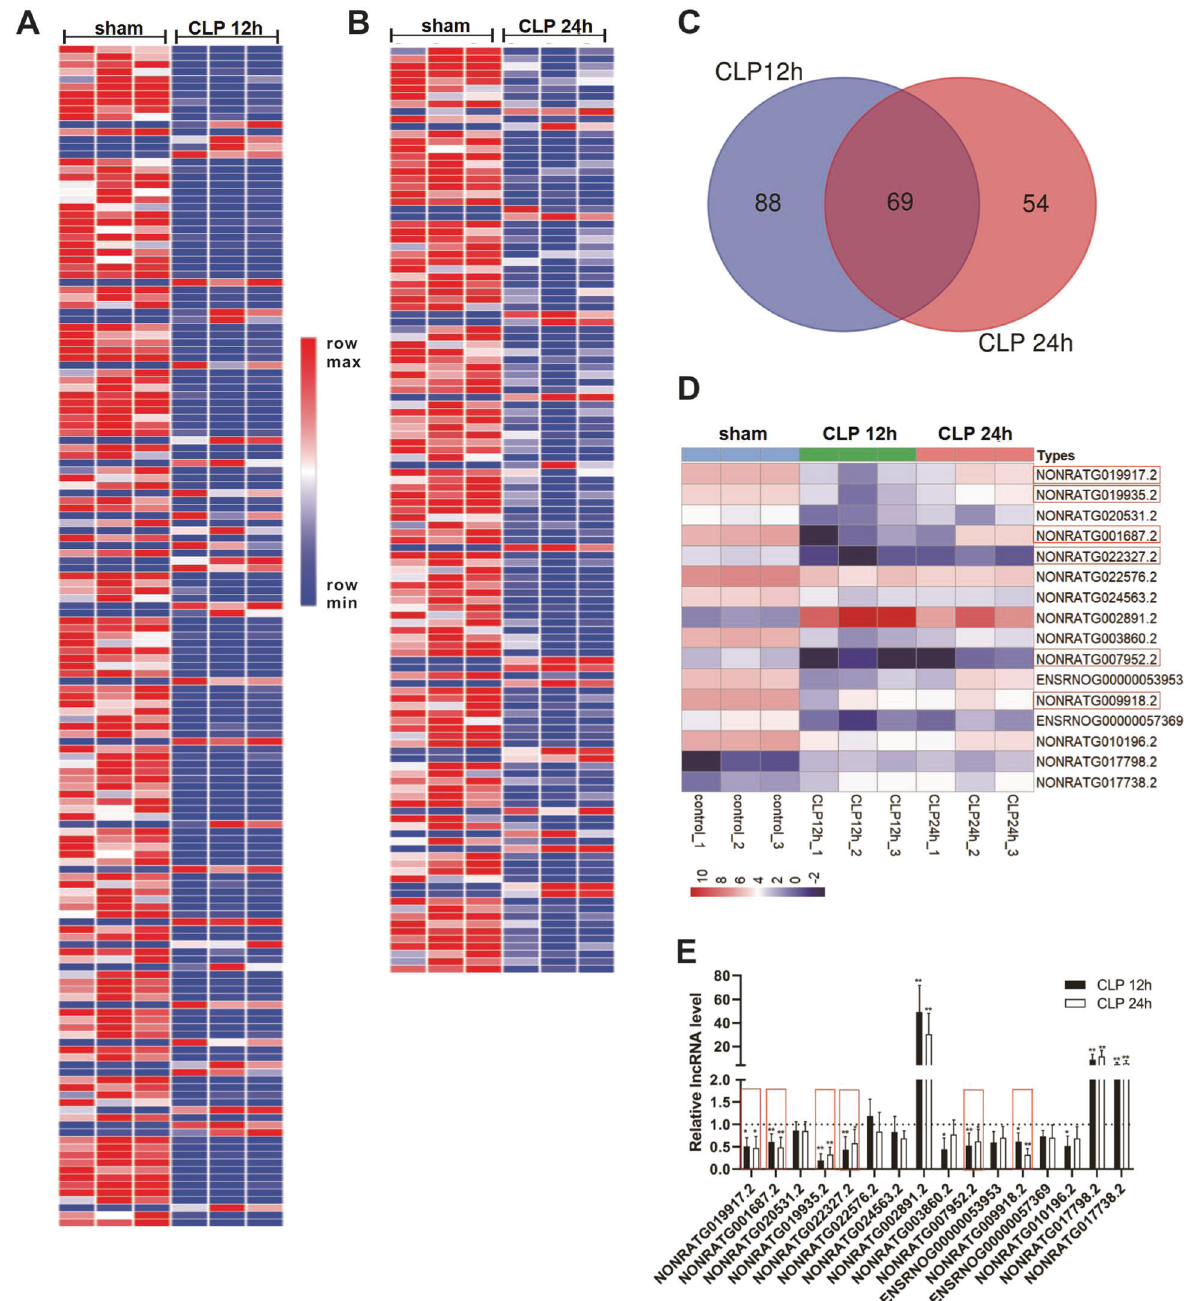
Fig. 1 Identi fi cation of differentially expressed lncRNAs (DE-Lncs) in cecal ligation puncture (CLP)-engendered acute kidney injury (AKI). Clustered heat map of the DE-Lncs in renal cortical of A CLP 12 h ( n = 3) and B CLP 24 h ( n = 3). Rows represent lncRNAs and columns represent tissue types. The color scale runs from blue (low intensity) to white (medium intensity), to red (strong intensity). C There were 69 common DE-Lncs between CLP 12 and 24 h group. D The heat map of the 16 known lncRNAs among 69 common DE-Lncs. E qRT-PCR analysis of the expression levels of 16 known lncRNAs in the renal cortical of rats in each group ( n = 5). * P < 0.05, ** P < 0.01 vs. sham group. 9935 (probe) or its negative control (NC, a sense biotin-labeled DNA To determine the interaction between HuR and Tp53 3 ′ untranslated oligomers against 9935) (all synthesized by Guangzhou Ribo Biotechnol- regions (UTR), the RNA pull-down assay was conducted using biotinylated- ogy Co., Ltd.), followed by the addition of streptavidin beads to extract the Tp53 3 ′ UTR (Biotin-Tp53 3 ′ UTR) as described above. RNA-protein complex. The enrichment of HuR in the pull-downed complexes was examined using western blot. For RNA pull-down assay, Western blot cell lysates of NRK-52E cells were incubated with a biotin-labeled 9935 Protein samples of 25 µg extracted from the NRK-52E cells, renal cortex, or probe (sense) or its negative control (antisense, a biotin-labeled antisense renal tubule were used for a single test. The experiments were conducted RNA of 9935), followed by the addition of streptavidin beads to extract the as previously described [18]. The primary antibodies used in this study RNA-protein complex. The enrichment of HuR in the pull-downed were as follows: anti-c-caspase 3 (1:500; Abcam, UK), anti-caspase 3 (1:500; complexes was examined using western blot. Cell Death and Disease (2021)